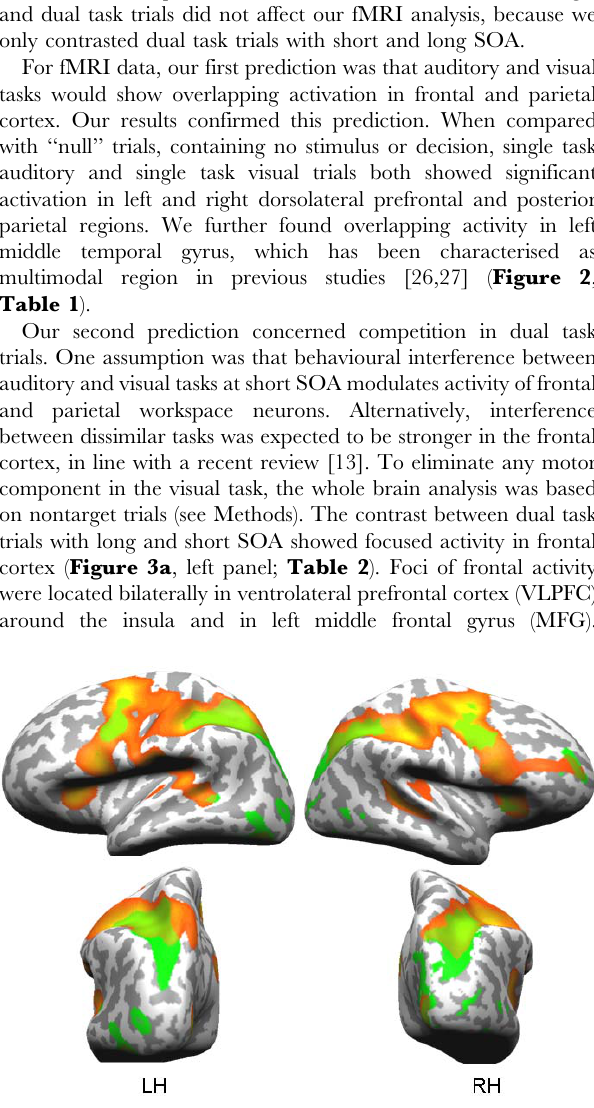
Figure 2. Significant activity (q(FDR) , .001 for both activation maps) for the contrast between single visual trials (orange) and single auditory trials (green) trials versus ‘null trials’ baseline. LH – left hemisphere, RH – right hemisphere. A list of cortical regions commonly activated by single visual trials and single auditory trials is provided in Table 1 .